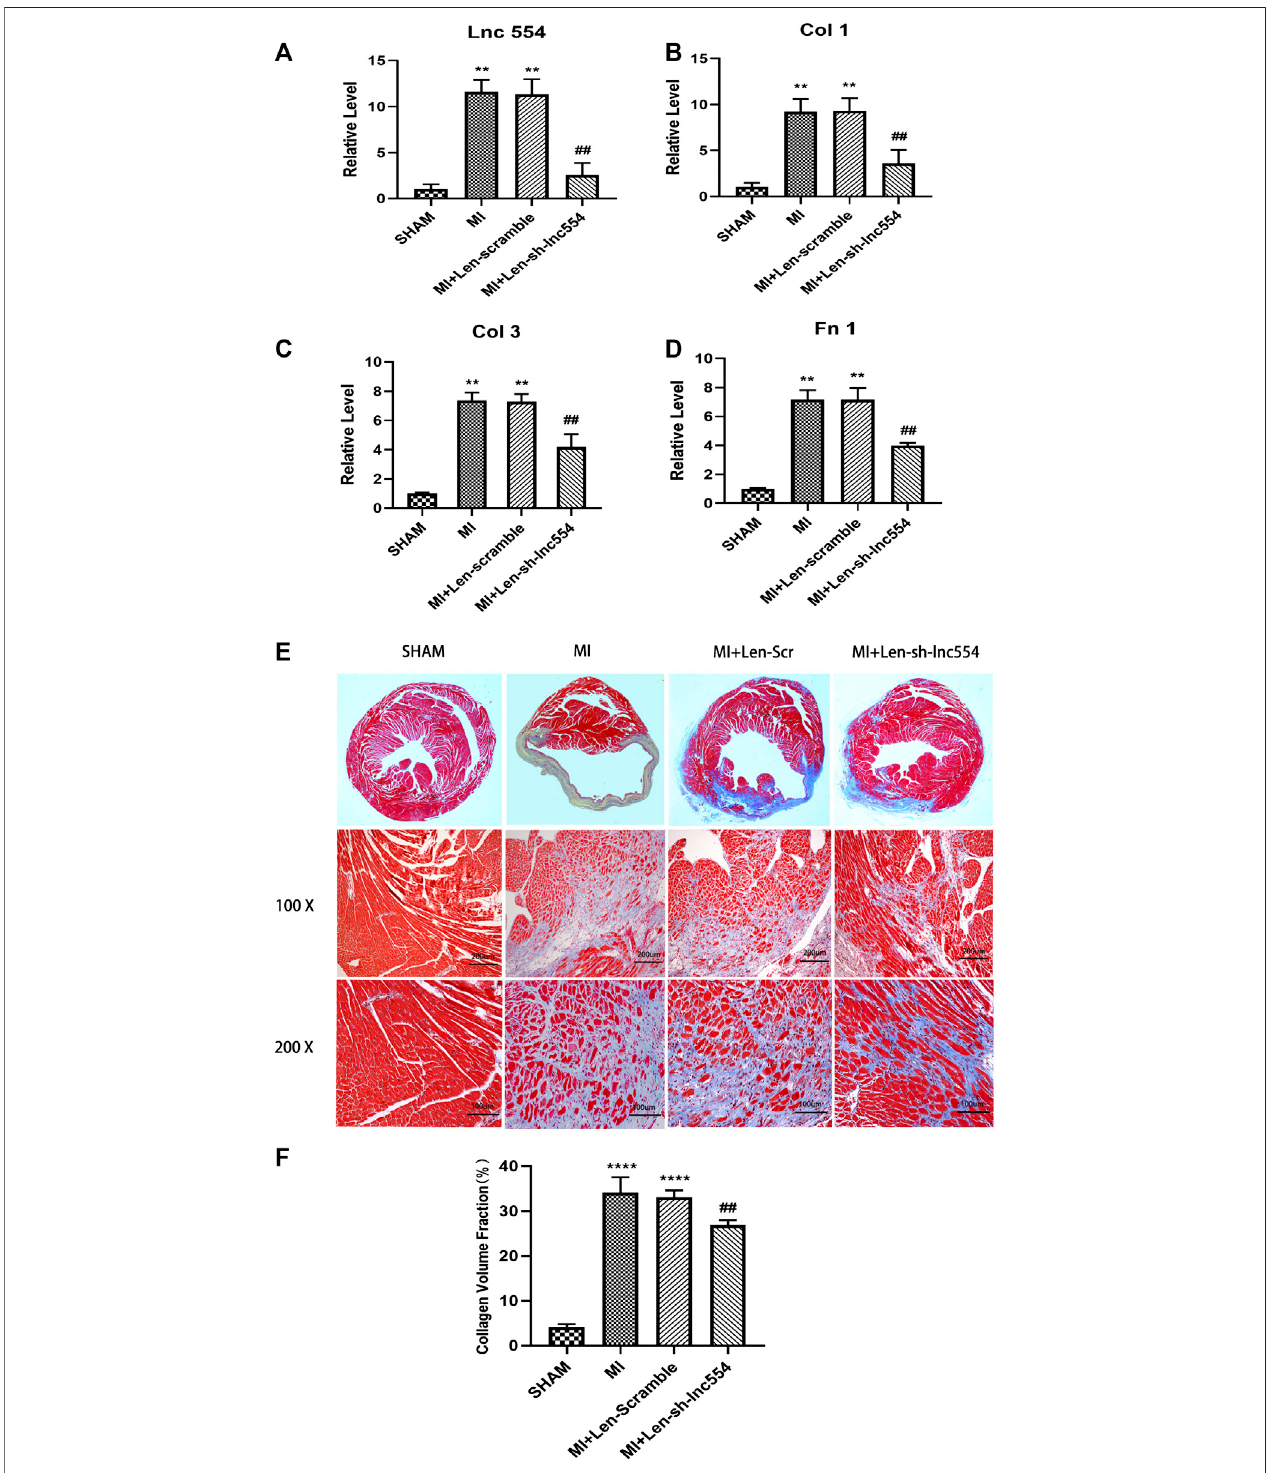
FIGURE4| KnockdownoflncRNA554mitigatescardiac fi brosisofinfarctedhearts.ToknockdownlncRNA554,theheartswereinjectedwithlentiviruscontaining controlorlncRNA554shRNAand subjectedtoqRT-PCRandMasson ’ strichrome stainingin14days after MI (A) Theexpression oflncRNA 554wasdetected byqRT- PCRinpost-MIhearts.** p < 0.01vsSHAM,## p < 0.01vsMI+Len-scramble,n (cid:2) 8.TheexpressionofCol1; (B) ,Col3; (C) and;Fn1 (D) mRNAinperi-infarctarea.** p < 0.01 vs SHAM, ## p < 0.01 vs MI + Len-scramble, n (cid:2) 8; (E) and (F) Representative images of Masson ’ s trichrome staining and a quanti fi cation of Masson ’ s trichrome staining show the degree of fi brosis. **** p < 0.0001 vs SHAM, ## p < 0.01 vs MI + Len-scramble, n (cid:2) 8.